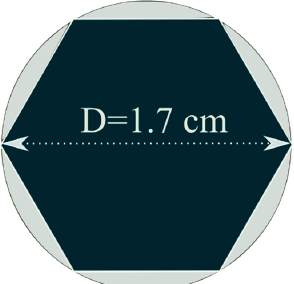
Figure A2. Top to bottom view of surfaces for cyclic potentiodynamic polarization (CPP) measurements, after addition of experimental crevice former (black). The circular area demonstrates the total exposure provided by an o-ring on the surface, and gray area represents the surfaces with direct contact to phosphate buffered saline (PBS) solution.